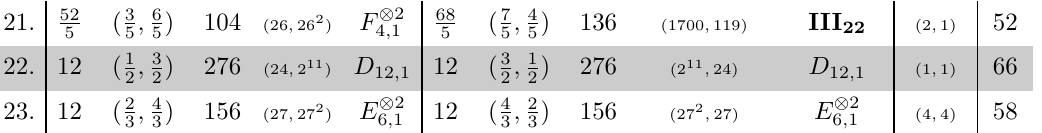
Table 8. CFT pairings, c H = 24 with ( n 1 , n 2 ) = (2 , 2) . The entry in the last column identifies the meromorphic theory by its row number in the table of [37].